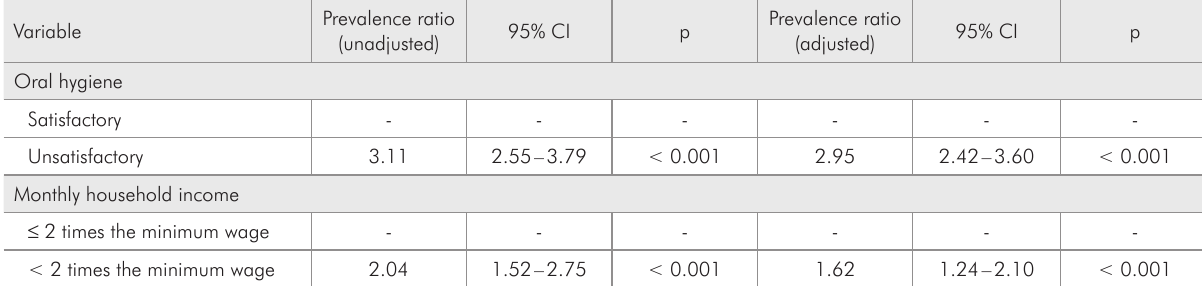
Table 3 - Prevalence ratios and confidence intervals for associations between ECC and associated variables (p <